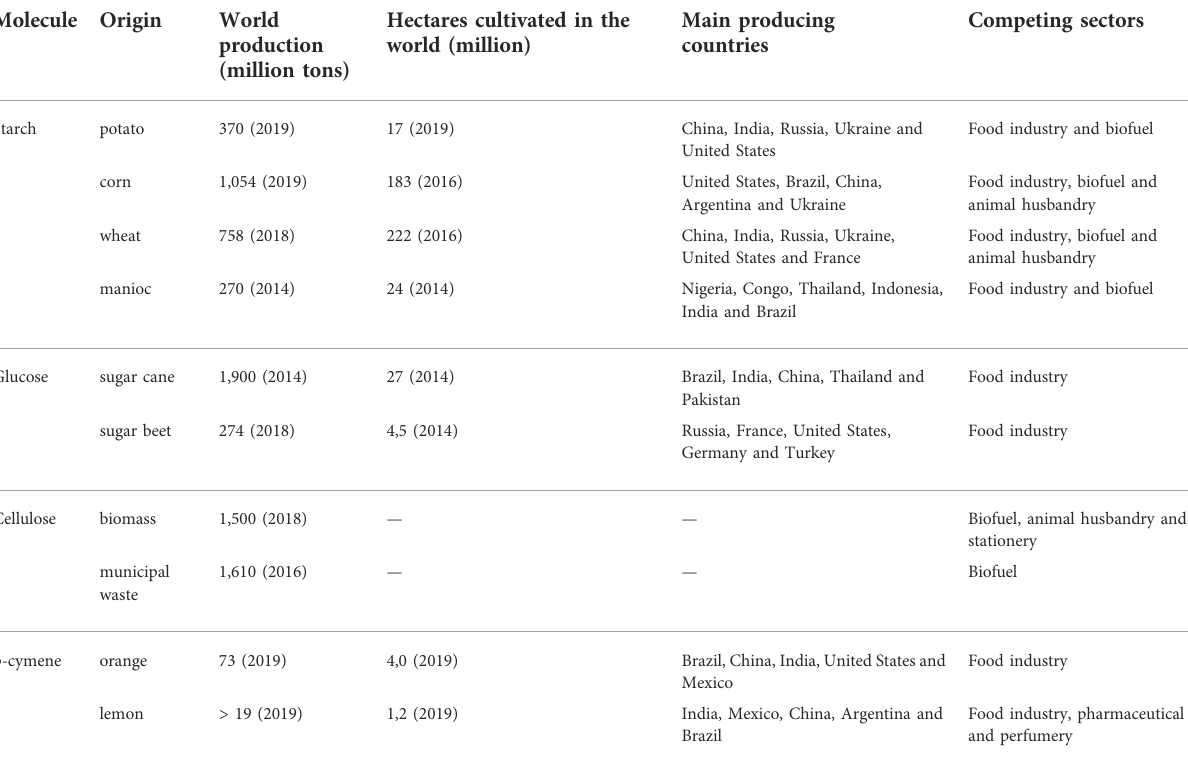
TABLE5Origin,productioncapacity,involumeandsurfacearea,mainproducersandcompetingsectorsfortheproductionofmoleculesusedasraw materials. Molecule